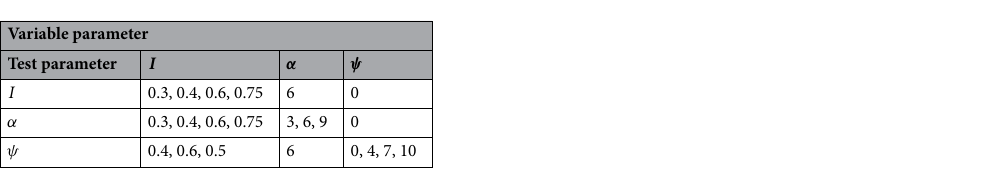
Table 5. Model propeller experimental test